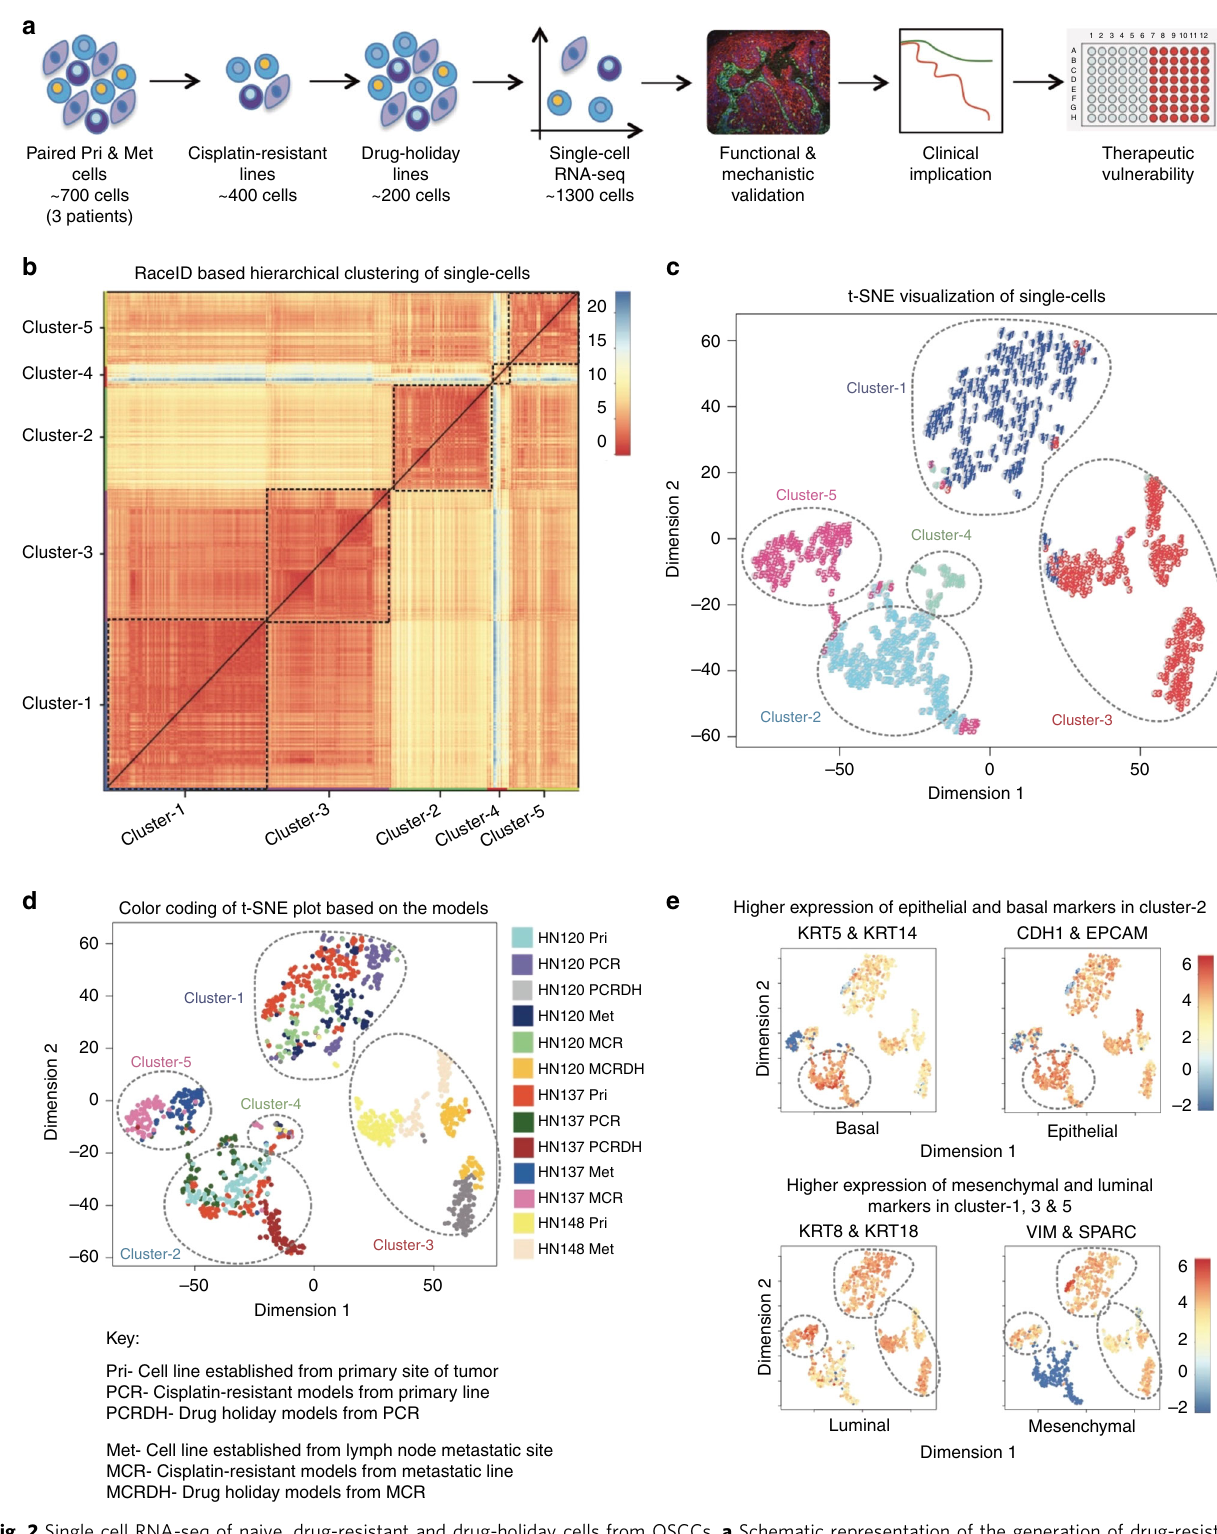
Pri- Cell line established from primary site of tumor PCR- Cisplatin-resistant models from primary line PCRDH- Drug holiday models from PCR Met- Cell line established from lymph node metastatic site MCR- Cisplatin-resistant models from metastatic line MCRDH- Drug holiday models from MCR Fig. 2 Single cell RNA-seq of naive, drug-resistant and drug-holiday cells from OSCCs. a Schematic representation of the generation of drug-resistant models and scRNA-seq work fl ow. b RaceID for Hierarchical k-means clustering of 1302 scRNA-seq libraries based on gene expression pro fi ling identi fi es fi ve major clusters. c t-SNE visualization of clusters identi fi ed from OSCC-PDPC scRNA-seq libraries. d Color-coding of t-SNE plot based on the identities of individual OSCC-PDPCs and their drug-resistant/holiday models. e Relative expression of genes associated with basal (KRT5/KRT14), luminal (KRT8/ KRT18), epithelial (EPCAM/Ecad), and mesenchymal (VIM/SPARC) markers on tSNE plot suggesting that the clusters represent distinch phenotypic